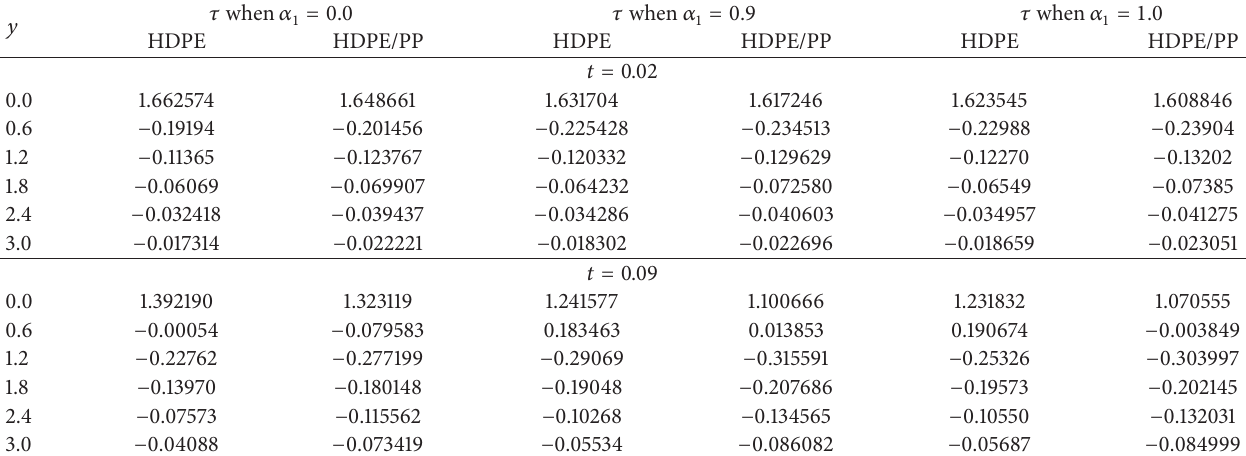
Table 6: Stress values of HDPE and HDPE/PP fluids for different 𝛼 1 when 𝛼 2 = 𝛽 1 = 𝛽 2 = 1 ; 𝑡 = 0.02, 0.09 .